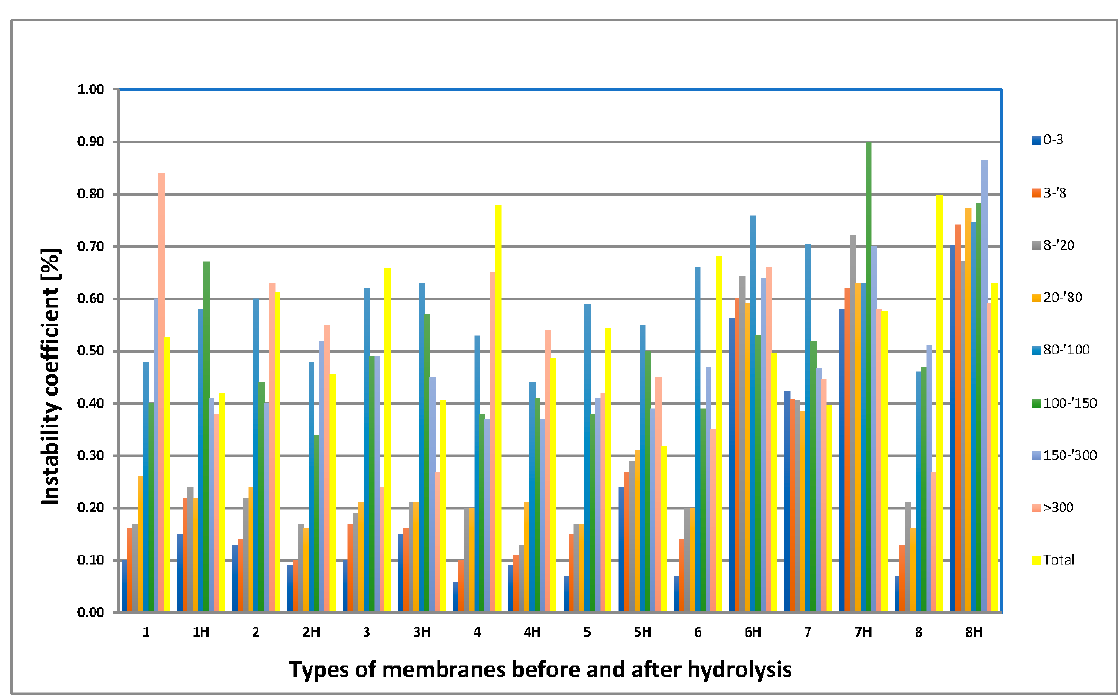
Figure 10. Influence of hydrolysis on the instability of membranes’ porosity in different types of membranes (horizontal axis) and size-classes of pores (groups of data).